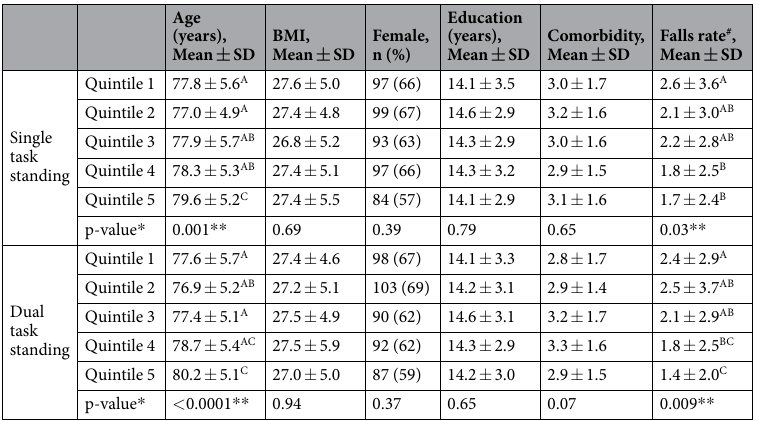
Table 4. Descriptive characteristics of participants in quintiles of postural sway complexity. # Falls were tracked for 48 months by using self-reported calendar. * ANOVAs and Student’s t post-hoc tests were used to determine the differences in these characteristics between quintiles. Within each column in ST and DT conditions, mean values with different superscript letters (A, B, or C) are significantly different from one another as determined by Student’s t post-hoc tests, P < 0.05. Note : BMI = body mass index.